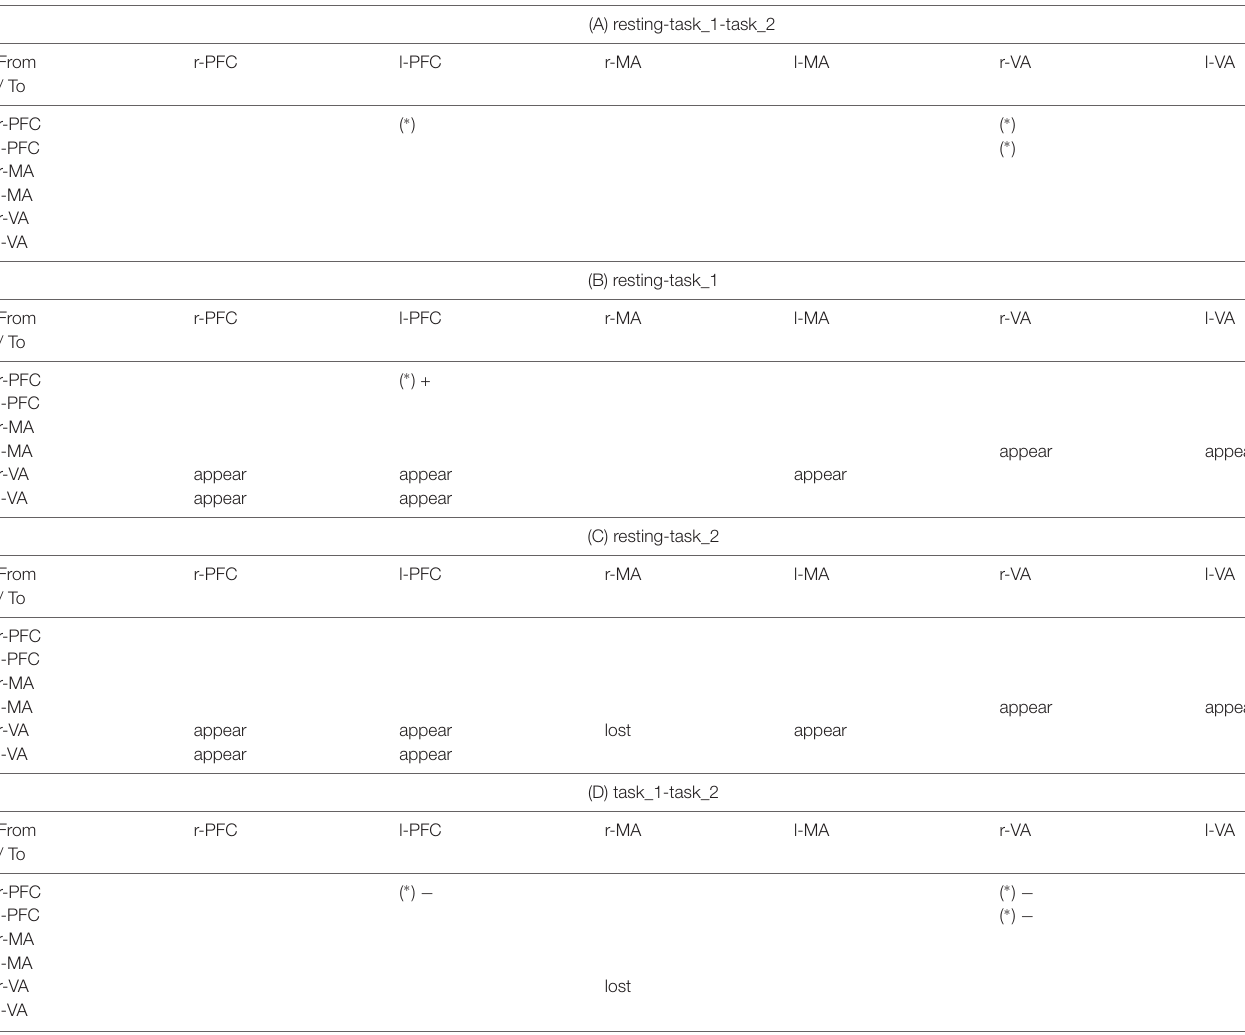
TABLE 2 | Comparison in the connection strength of the subjects among three states (A; resting-task_1-task_2), (B; resting-task_1), (C; resting- task_2) and (D;